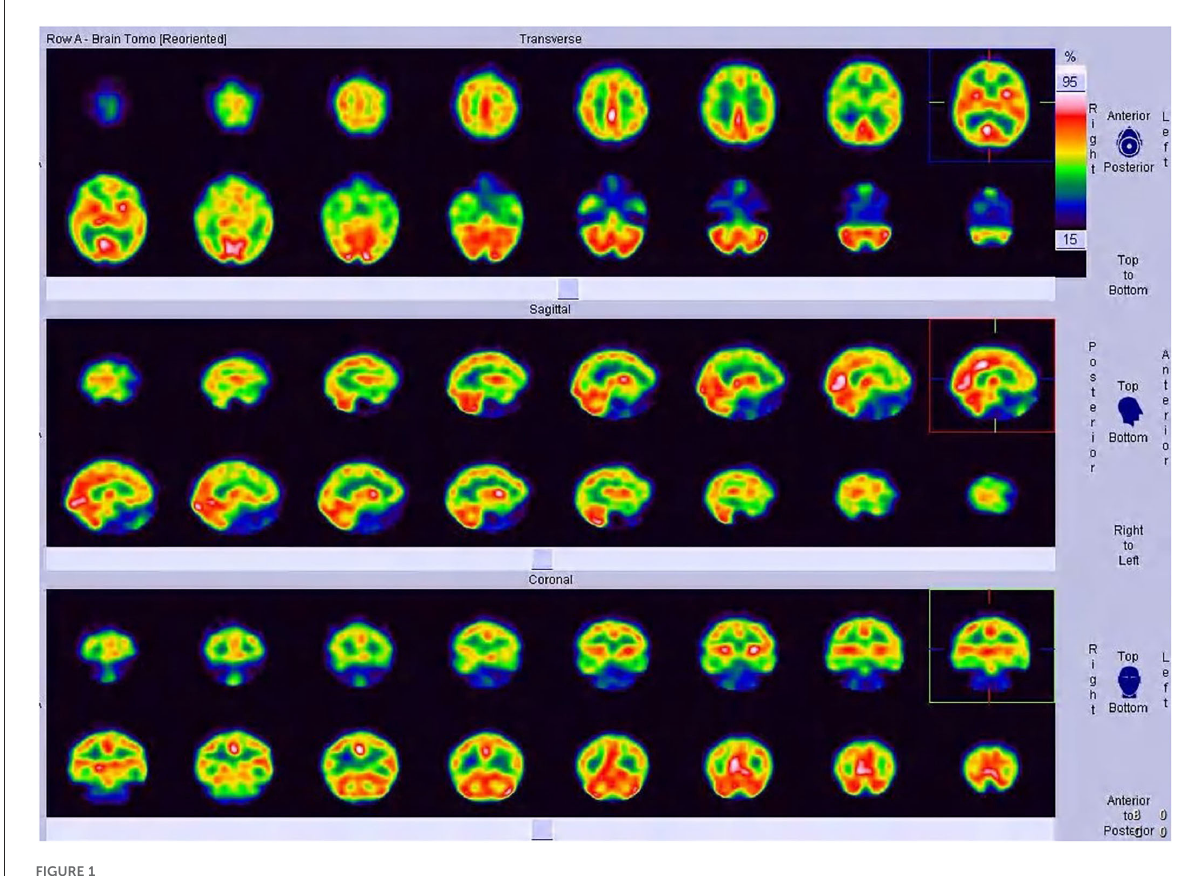
FIGURE1 SPECT images of Case 2, a 19-year-old